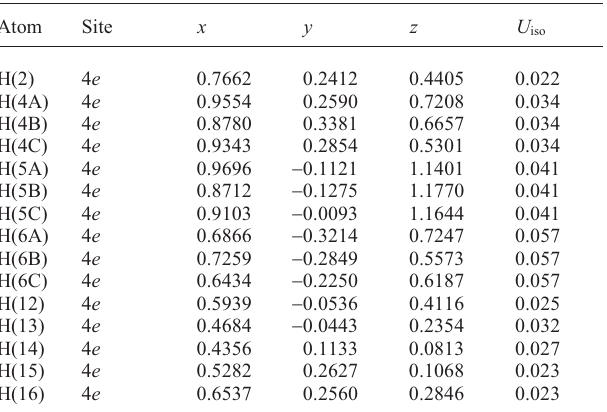
Table 2. Atomic coordinates and displacement parameters (in Å 2 )